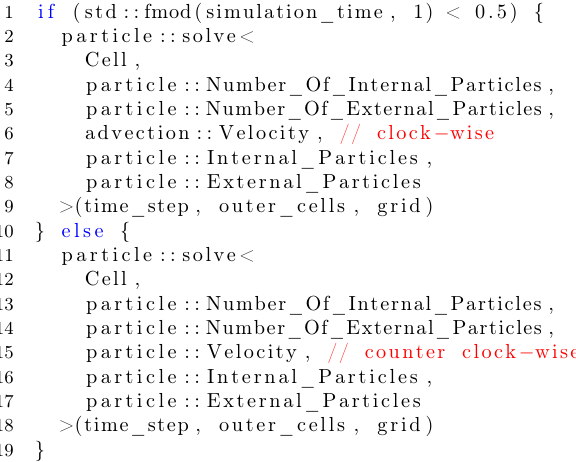
Table 2. Run-times of serial GoL programs using different cell types and memory layouts for their variables compiled with